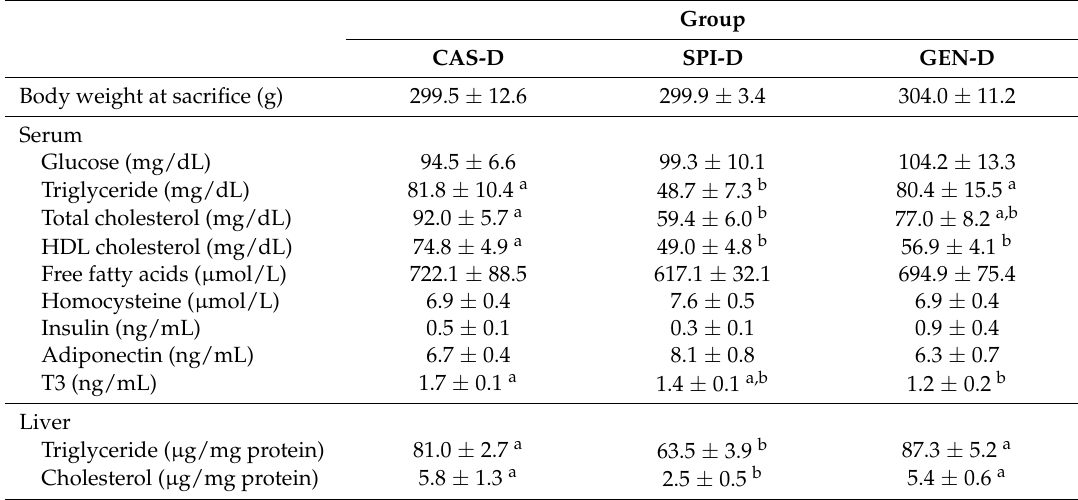
Table 2. Effects of diets on the serum and hepatic biochemical parameters of dams.